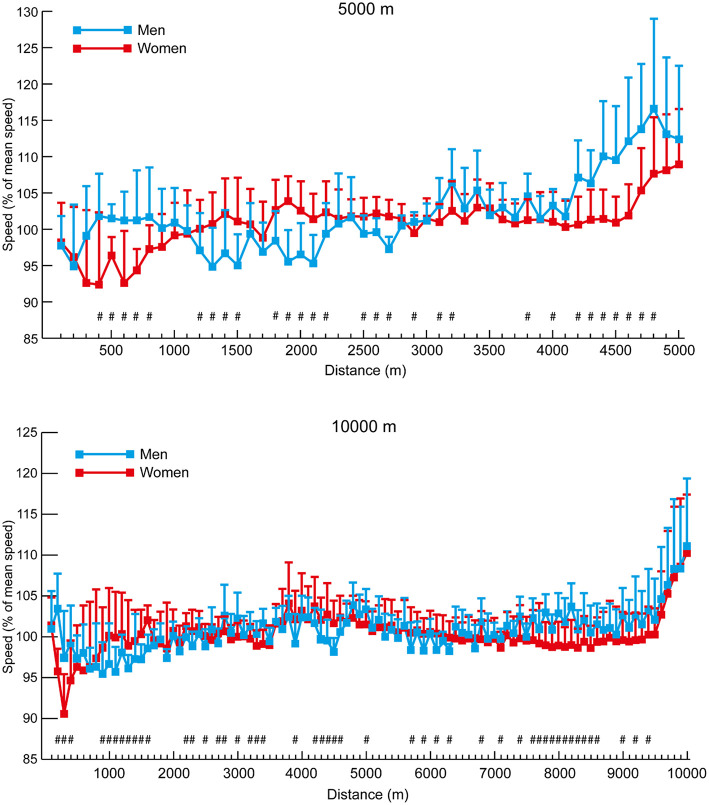
The mean (+ SD) section speed expressed as a percentage of mean speed for all men and women in the 5,000 and 10,000 m events. Differences in segment speed percentage between men and women (p < 0.05, d ≥ 0.61) have been annotated (#).